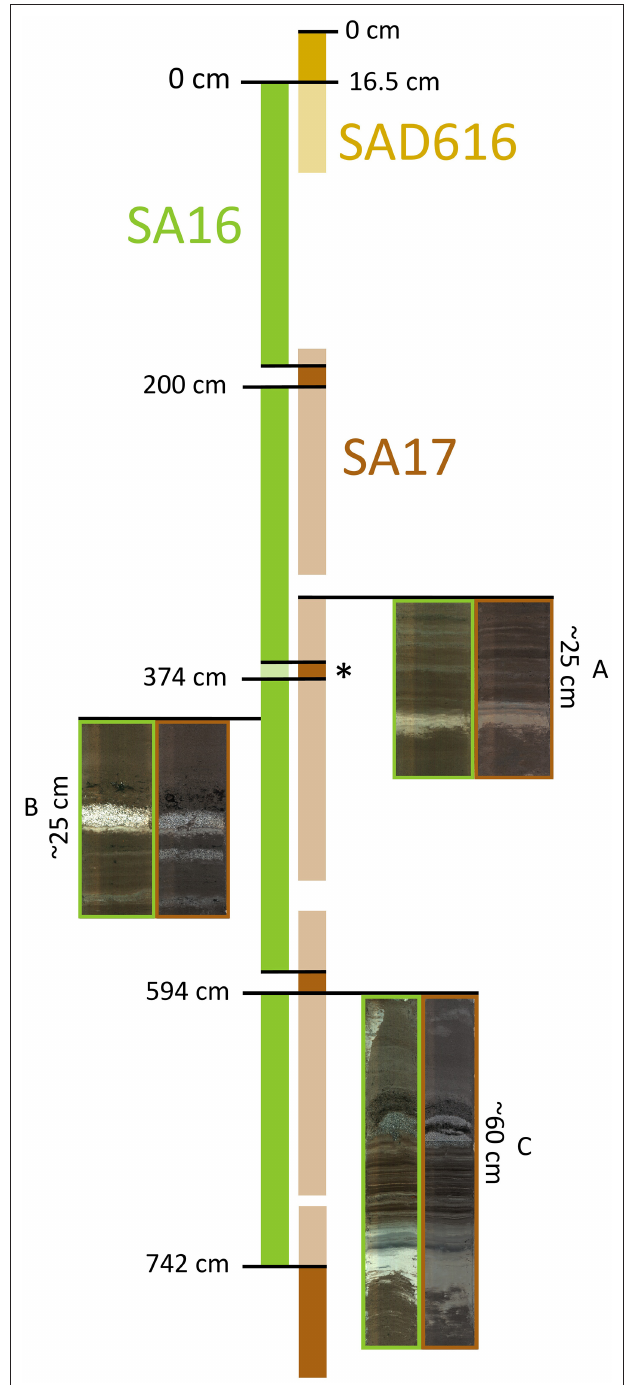
FIGURE 10 | Image showing how the three cores from Lake Sandvinvatnet are stacked: SAD616 (yellow) at the top; the main piston core, SA16 (green), to the left; and the piston recovery core, SA17 (brown), to the right. The shaded parts of the cores are not included in this study. The composite core is correlated mostly with visual layers, as exemplified by sections (A–C) . At the top and bottom of SA17, age and magnetic susceptibility (MS) are employed to guide the inter-core correlation. SAD616 is correlated only by age. *At this depth, the two cores have different compaction rates; hence, there is no space between SA16 at this depth when compared with